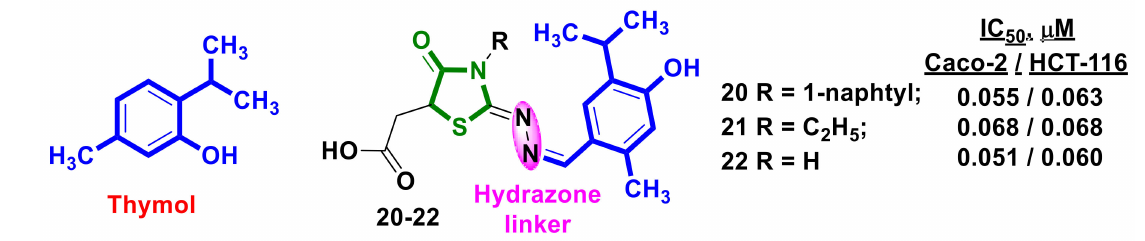
Figure 9. Structures of 4-thiazolidinone hybrids with thymol moiety in the molecules.